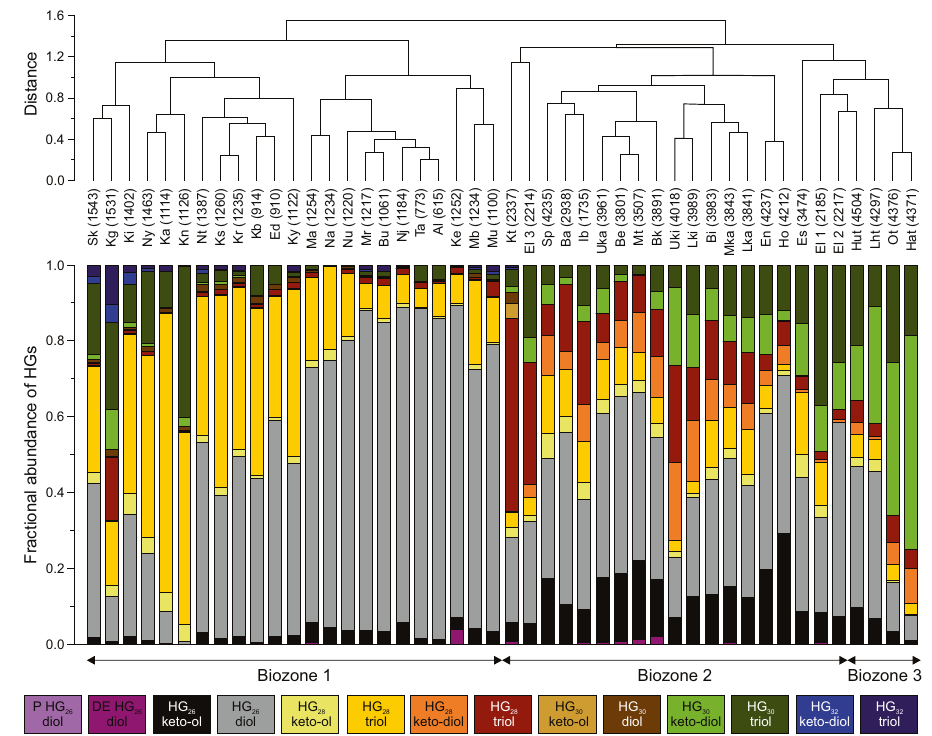
Fig. 3 Hierarchical clustering of East African lakes based on the sedimentary distribution of heterocyte glycolipids (HGs). The distance in the similarity of HG patterns indicates that three biozones, each characterized by distinct cyanobacterial communities, exist along the altitudinal gradient. Biozone 1 comprises low-elevation lakes (615 to ~1550 masl) and shows abundant HG 26 diols and HG 28 diols that are speci fi c to nostocalean cyanobacteria belonging to the genera Anabaena and Anabaenopsis 17,18 . Biozone 2 constitutes of mid-elevation lakes (~1550 masl to ~4300 masl). Surface sediments of these lakes contain more diverse HG distribution patterns and higher relative abundances of HG 28 triols and HG 30 triols. The latter are found in heterocytous cyanobacteria of the benthic mat-forming families Rivulariaceae (e.g. Calothrix spp.) 18,19 and Scytonemataceae (e.g. Scytonema spp.) 25 . Biozone 3 (>4300 masl) includes shallow, high-elevation tarns that are characterized by abundant HG 30 triols and HG 30 keto-diols, which points to a predominant contribution of mat-forming heterocytous cyanobacteria of the genus Scytonema 25 . Note that only the summed fractional abundance of individual HGs is shown as the overall HG distribution pattern is speci fi c for the cyanobacterial community composition. Lake abbreviations are provided in Supplementary Table 1. Numbers in brackets indicate the altitudinal position of the lake (0.02) and HG 28 keto-diols (<0.01), as well as HG 30 triols (0.04)